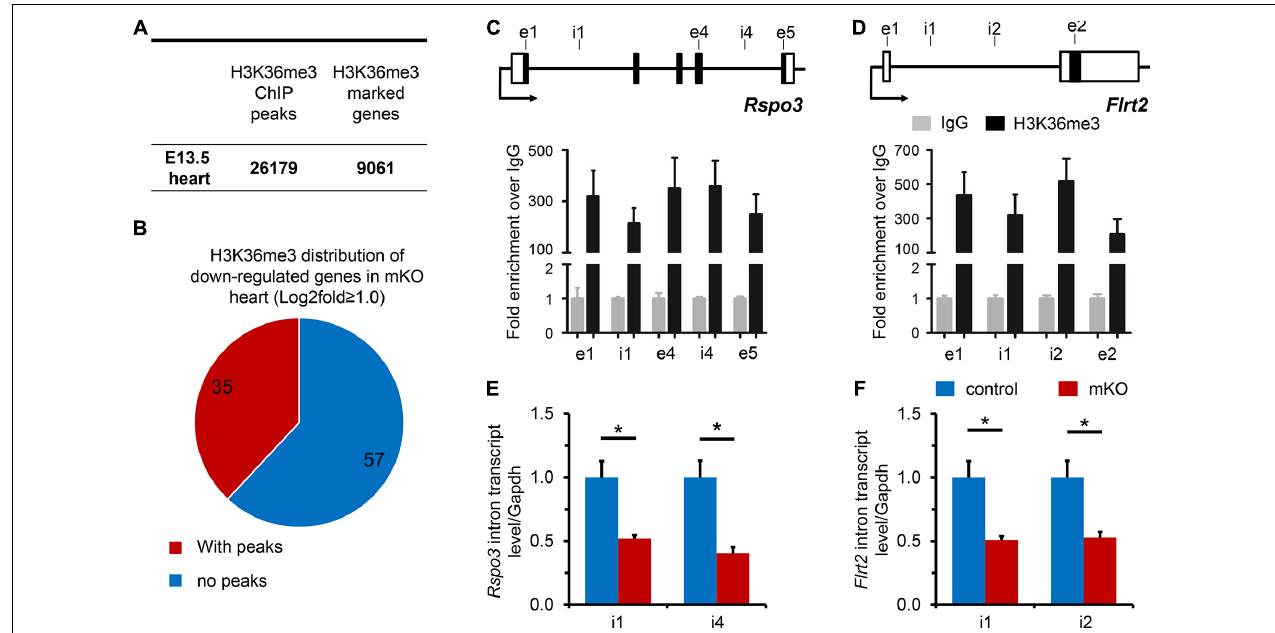
FIGURE 4 | H3K36me3 is required for Rspo3 and Flrt2 transcription in the heart. (A) The numbers of H3K36me3 ChIP-seq peaks and H3K36me3 marked genes in E13.5 embryonic hearts. (B) Pie diagram illustration of H3K36me3 enrichment on downregulated genes in mKO hearts revealed by mRNA-seq. The numbers of genes were labeled in the graph. (C,D) ChIP-qPCR analysis of H3K36me3 occupancy to the locus of Rspo3 and Flrt2 genes, using IgG as the control. The locations of primers are indicated in the upper diagram. n = 3 for each group. Each bar represents the mean ± SEM. i, intron. e, exon. (E,F) qPCR analysis of the expression of Rspo3 and Flrt2 heterogeneous nuclear RNA introns in control and mKO hearts, using the primers indicated in the upper diagram of panels (C,D) , respectively. n = 5 for each group. All data represent mean ± SEM. Significance was determined by two-tailed, unpaired Student’s t test. * p < 0.05 versus